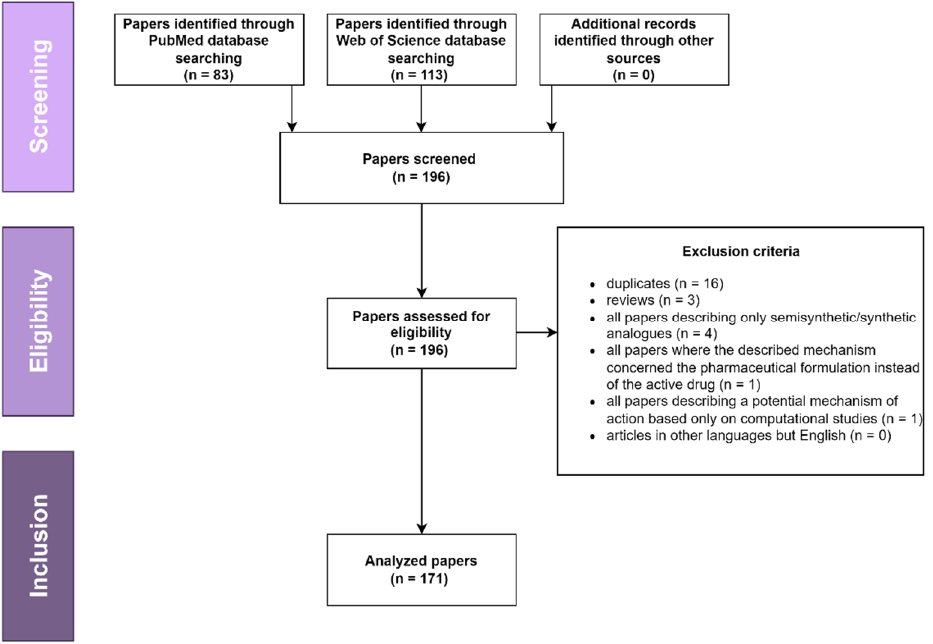
Figure 2. Flow diagram describing the data selection process.